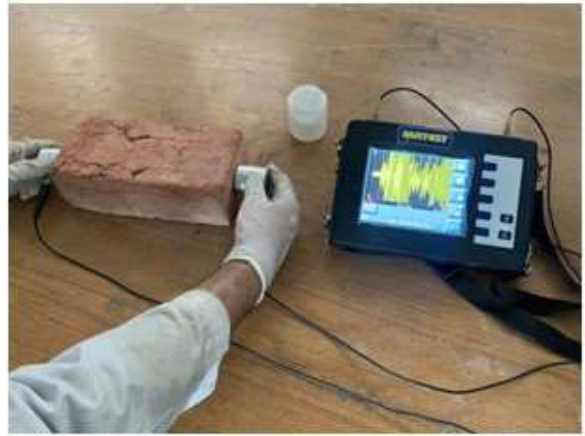
Figure 2. Scrubbed surface of new brick specimens.